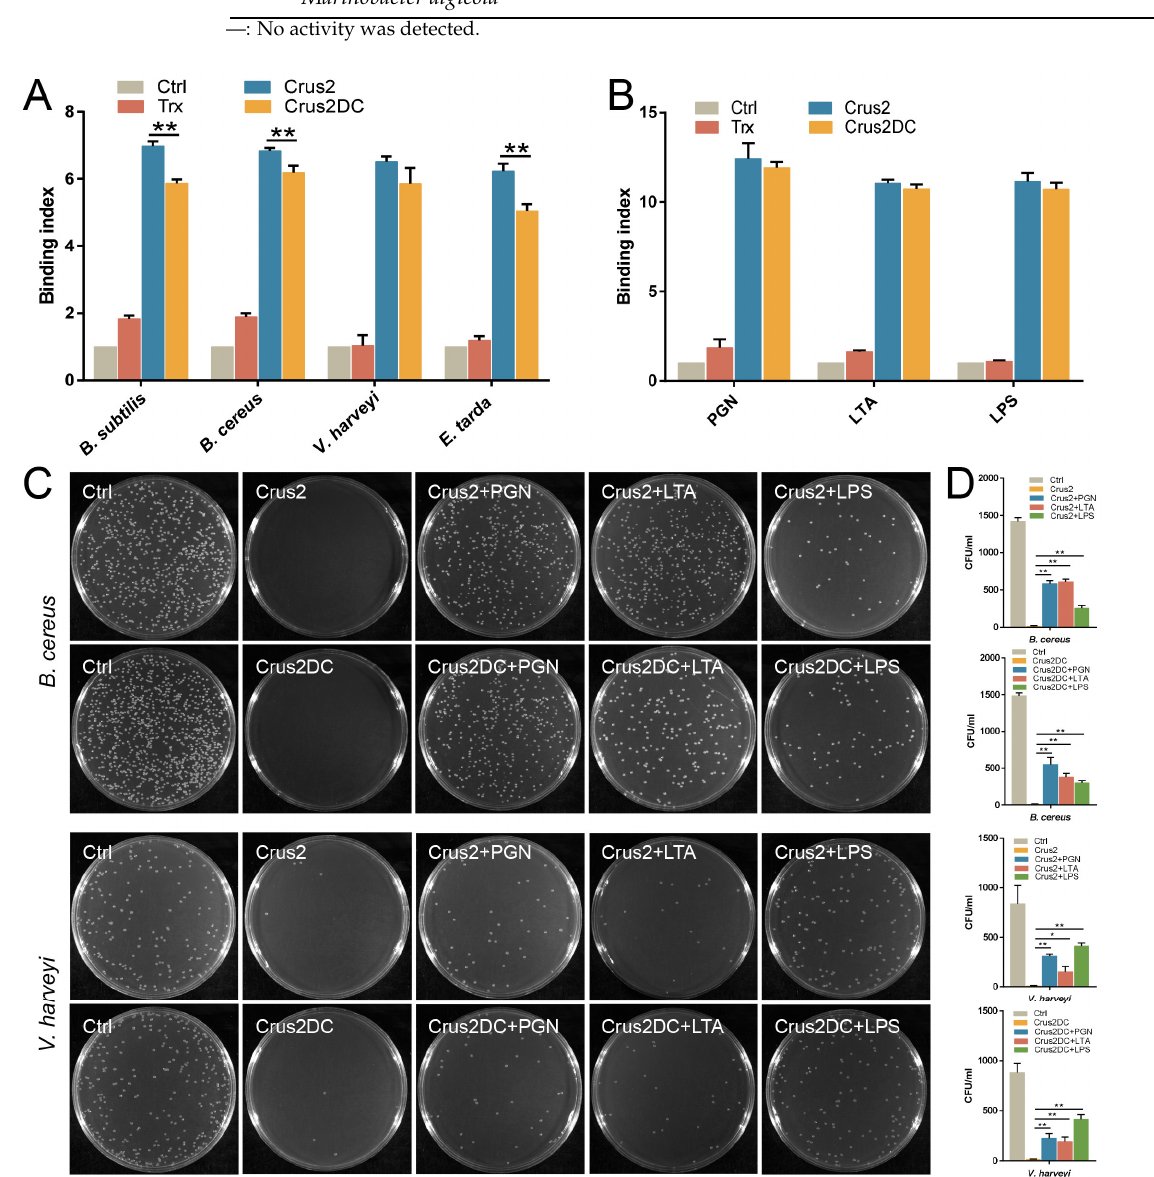
Figure 2. Binding of Crus2 and Crus2DC to bacteria and bacterial components. ( A ) Bacteria were incubated with or without (control, Ctrl) Crus2, Crus2DC, or rTrx, and the binding was detected by ELISA. ( B ) Peptidoglycan (PGN), lipoteichoic acid (LTA), and lipopolysaccharide (LPS) were incu- bated with or without (Ctrl) Crus2, Crus2DC, or rTrx, and the binding was detected as above. ( C , D ) Bacillus cereus and Vibrio harveyi were incubated with Crus2 or Crus2DC, or Crus2/Crus2DC that had been pre-treated with PGN, LTA, or LPS. The control bacteria were incubated with PBS. After 1 h of incubation, the bacteria were plated on MH agar plates and observed after 20–24 h incubation ( C ). The numbers of colony-forming units (CFU) on the plates were counted ( D ). Values are shown as means ± SD ( n = 3). n , the number of replicates. **, p < 0.01; *, p < 0.05 (Student’s t test). Propidium iodide (PI) staining showed that following treatment with Crus2/Crus2DC, strong fluorescence was observed in B. cereus and V. harveyi , reflecting